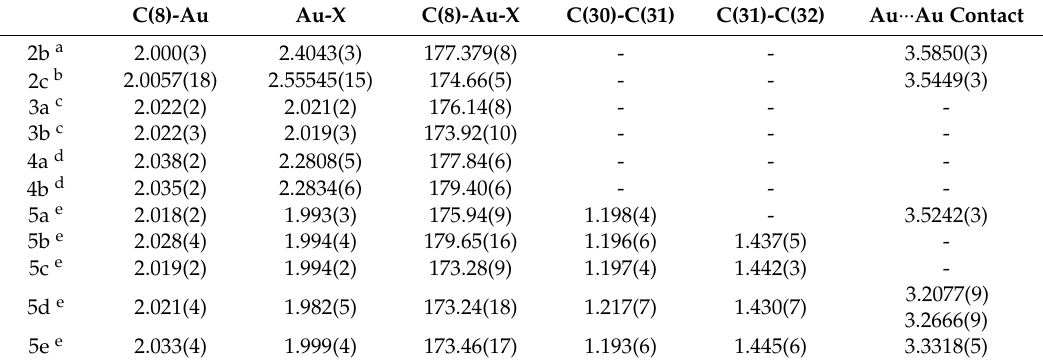
Table 1. Selected bond lengths (Å) and angles ( ◦ ) of complexes 2b – 5e